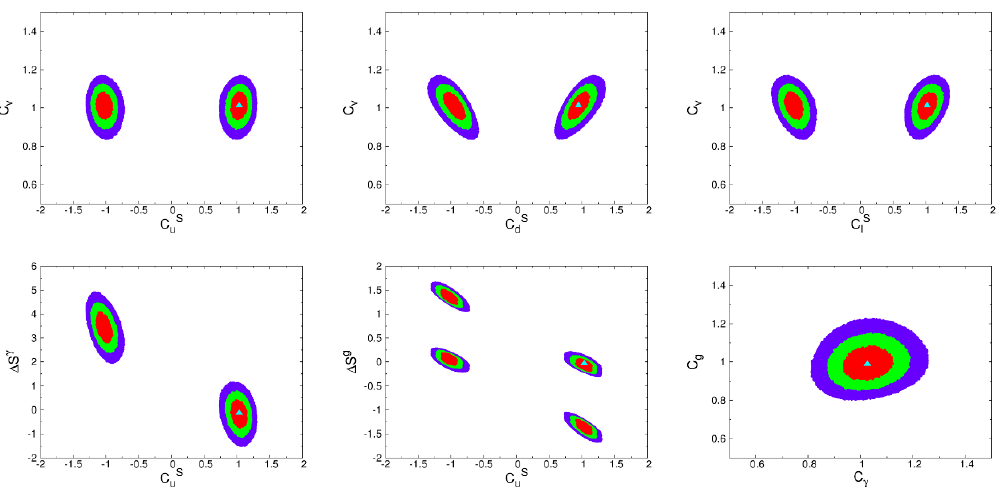
Figure 5 . CPC6 : the con(cid:12)dence-level regions of the (cid:12)t by varying (cid:1) S (cid:13) , (cid:1) S g , C v , C S C S . The color code is the same as (cid:12)gure ‘